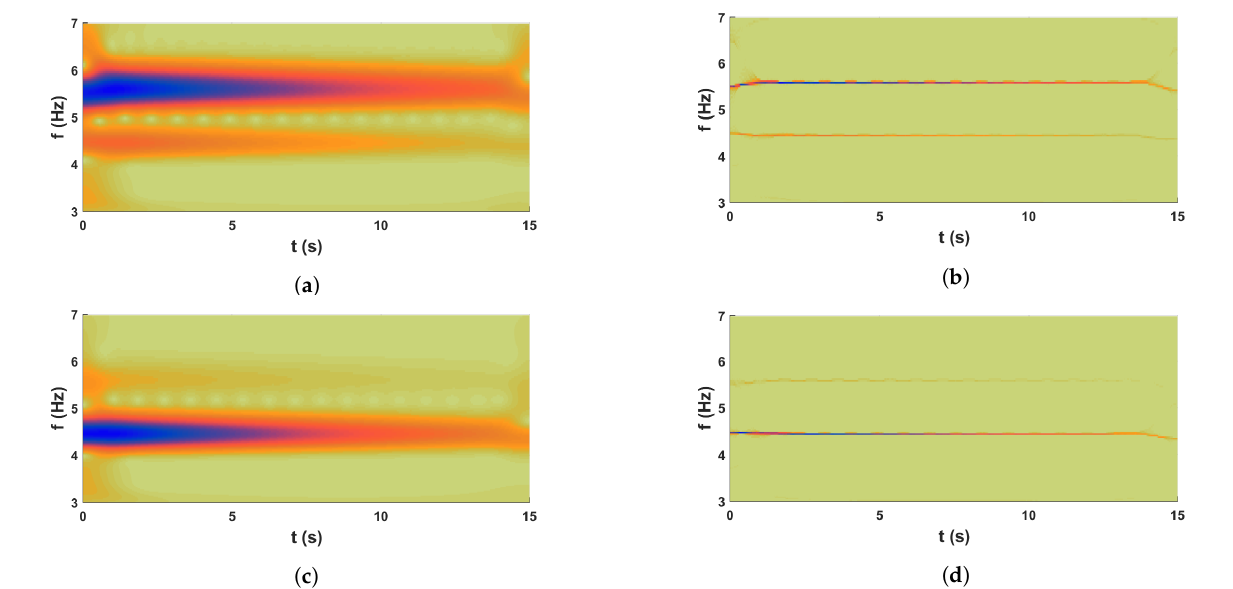
Figure 3. Scalogram; ( a , c ) are wavelet transform of u 1 & u 2 , respectively, and ( b , d ) are syn- chrosqueezed transform of u 1 & u 2 , respectively.